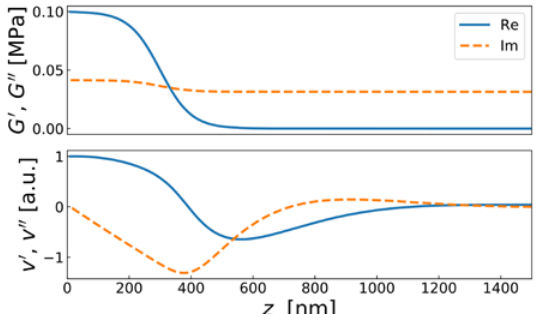
Figure 23. Top: The shear modulus as assumed in the Python code in Appendix C.1. Bottom: Normalized velocity profile resulting from a numerical solution of the wave equation (Equation (64)) with G ( z ) as shown at the top. The density was assumed as constant. Δ f and ΔΓ are computed from the slope of the velocity profile at z = 0.